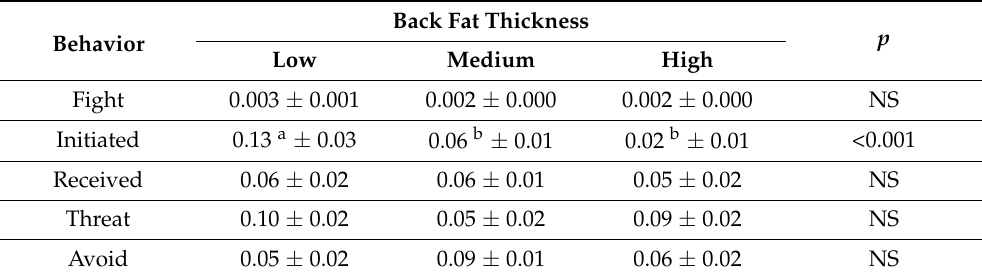
Table 3. Number of aggressive behaviors per hour according to back fat thickness (low, medium, and